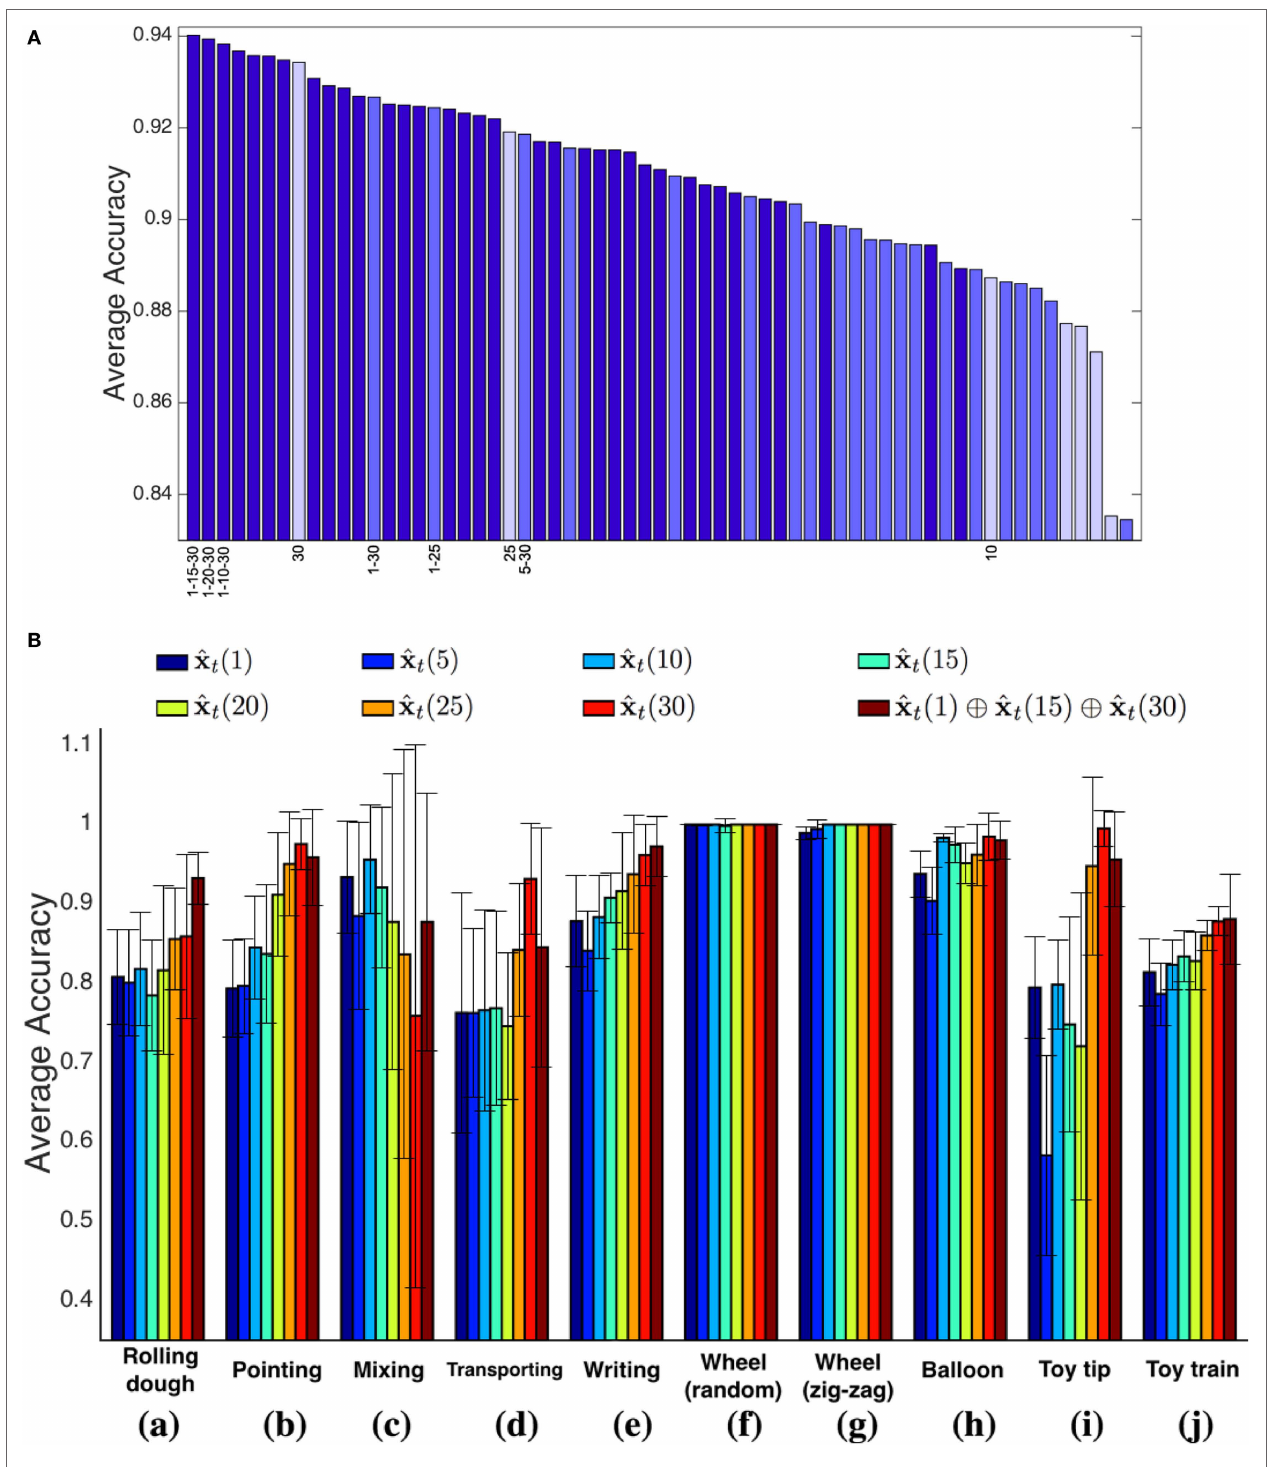
FIGURE 4 | (A) Average accuracy for each representation (dark blue: concatenation of three temporal windows; medium blue: concatenation of two temporal windows; light blue: a single temporal window). (B) A comparison between the selected temporal multi-resolution descriptor and all the different time widths considered independently. The results refer to the actions of Figure 3